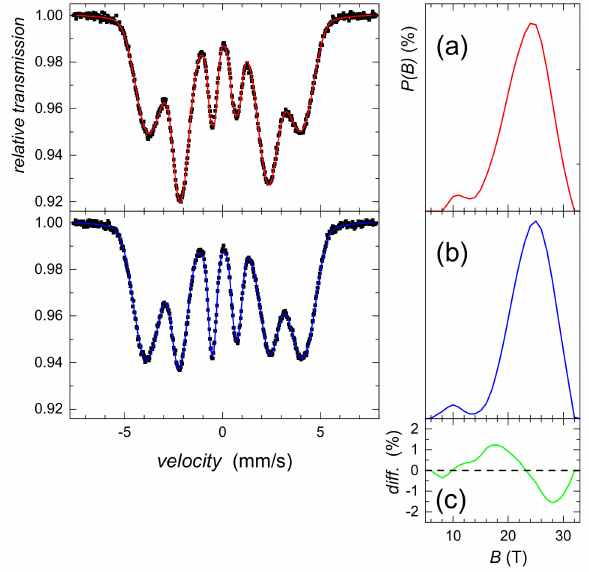
Figure 3. Mössbauer spectra (left) of the Fe 80 Cr 2 Si 14 B 14 amorphous metallic alloy with corresponding distributions of hyperfine magnetic fields, P ( B ), (right): ( a ) Non-irradiated sample; ( b ) after neutron irradiation with a fluence of 10 19 n/cm 2 ; ( c ) differences between P ( B ) distributions. Changes in P ( B ) distributions between the non-irradiated and irradiated specimens are highlighted in Figure 3c. Positions of zero differences are denoted by straight dashed lines.